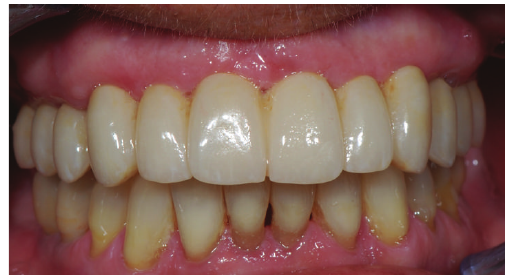
Figure 5: Panoramic radiograph after immediate loading.